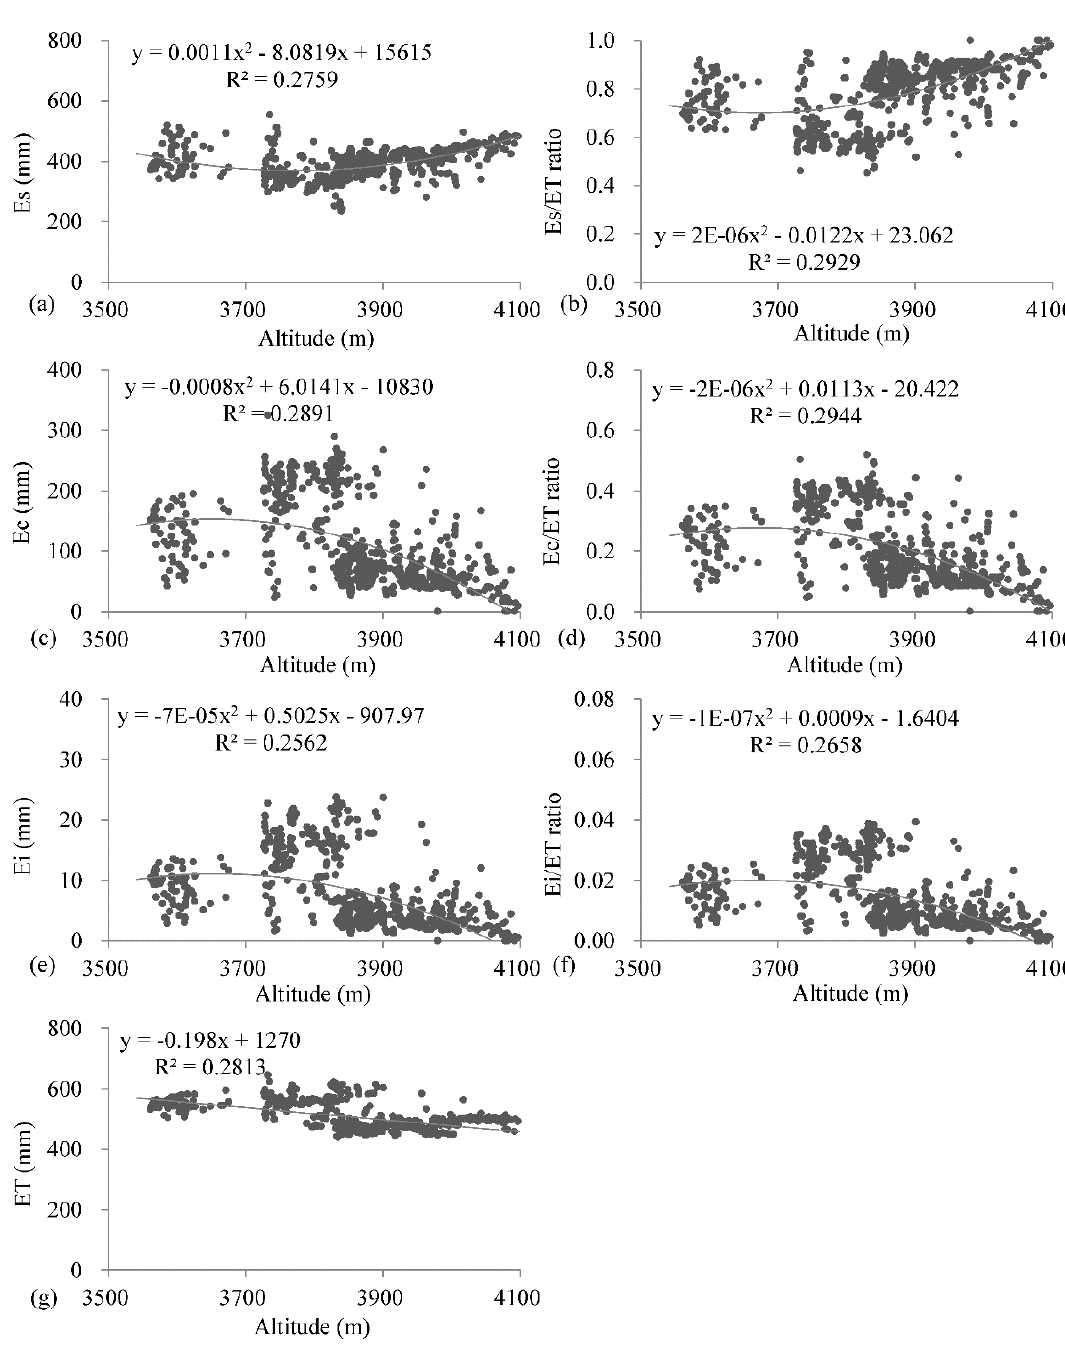
Figure 2. Relationship between altitude and Es ( a ), Es/ET ( b ), Ec ( c ), Ec/ET ( d ), Ei ( e ), Ei/ET ( f ), and ET ( g ).